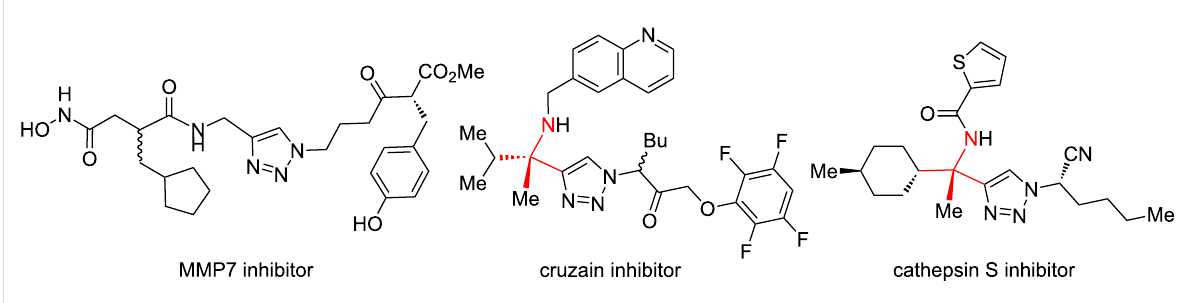
Figure 1: A sampling of propargylamine-derived triazoles with therapeutic effects includes alpha-tetrasubstituted triazoles as cruzain and cathepsin inhibitors.